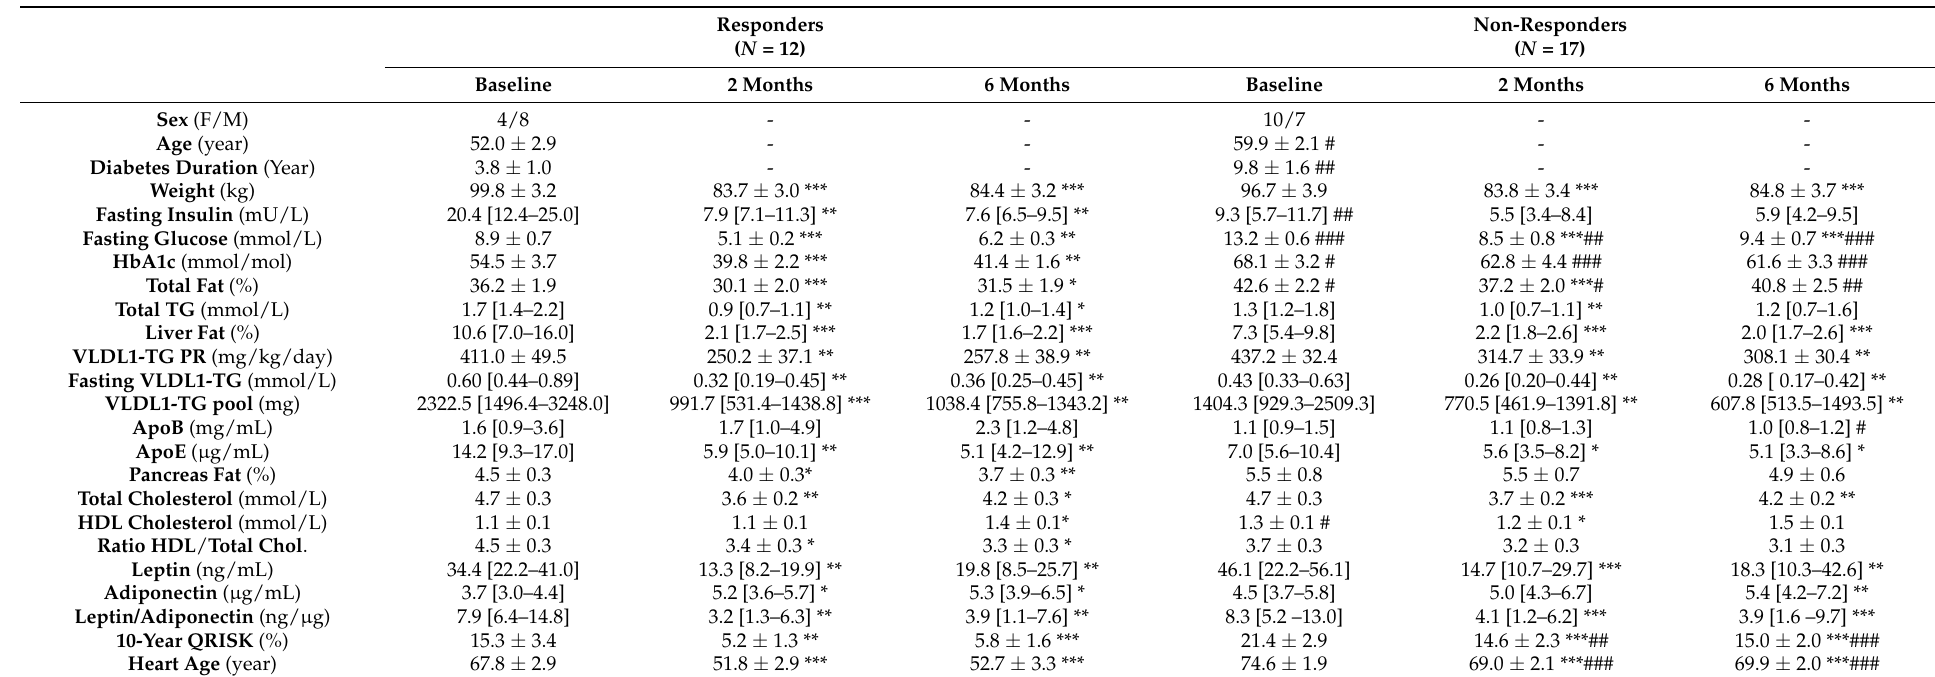
Table 1. Clinical and metabolic characteristics of the studied groups at baseline and after